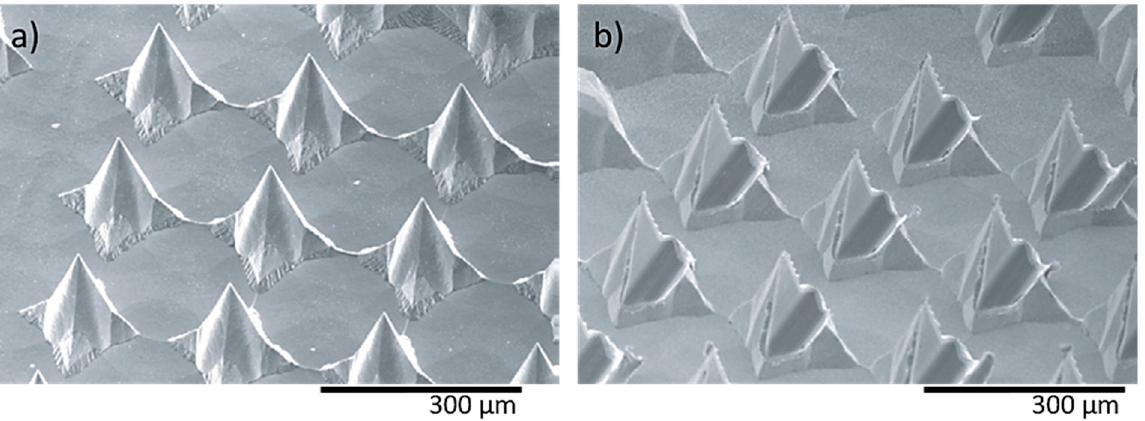
Figure 9. Nickel MN arrays ( a ) pyramid shaped needles (needle height: 120 µm) and ( b ) flattened needles (needle height: 170 µm), fabricated by the etching process for supplying medical solutions. Reprinted with permission from Ref. [122]. 2006, Journal of Micromechanics and Microengineering.